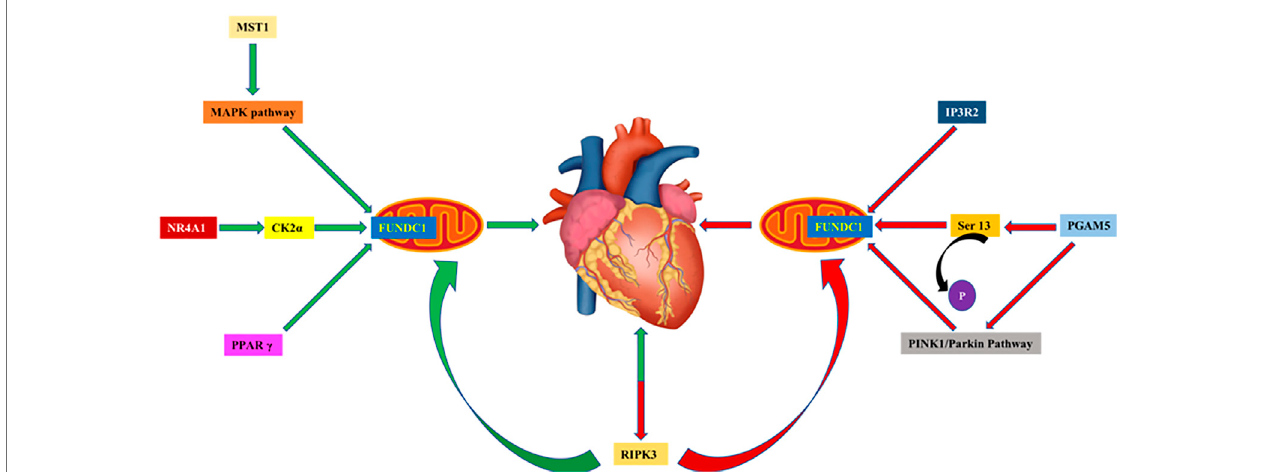
FIGURE 2 | 1) By interacting with IP3R2, knocked-out FUNDC1 in cardiomyocytes compromises mitochondrial function, disrupts MAMs and Ca 2+ in fl ux into mitochondria and cytosols. 2) PGAM5 dephosphorylates FUNDC1 at Ser 13 and activates mitophagy through binding with LC3 motif on phagocytes. PGAM5 provides cytoprotection against necroptosis by promoting PINK1-mediated mitophagy, and PGAM5 injury aggravates necroptosis caused by I/R injury in hearts and brains. 3) Upregulation of MST1 inhibits FUNDC1-mediated mitophagy through MAPK in I/R injury, increases ROS production and promotes cell apoptosis. 4) NR4A1 activates CK2 α during MI/R, leading to the inhibition of FUNDC1-mediated mitophagy and aggravation of I/R injury. 5) PPAR γ activates FUNDC1-mediated mitophagy, enhances mitochondrial function and ATP generation. 6) Reperfusion injury disrupts FUNDC1-mediated mitophagy and triggers caspase 9-related apoptosis through upregulation of RIPK3. RIPK3 de fi ciency protects against I/R injury through activation of mitophagy and inhibition of